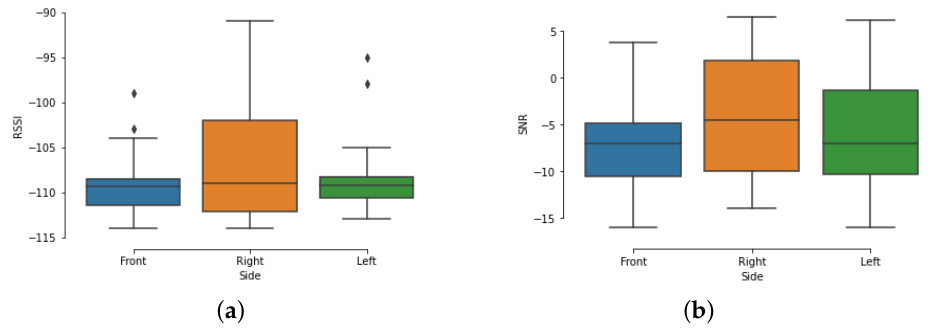
Figure 29. Average RSSI and SNR per side LoRaWAN. ( a ) RSSI. ( b )